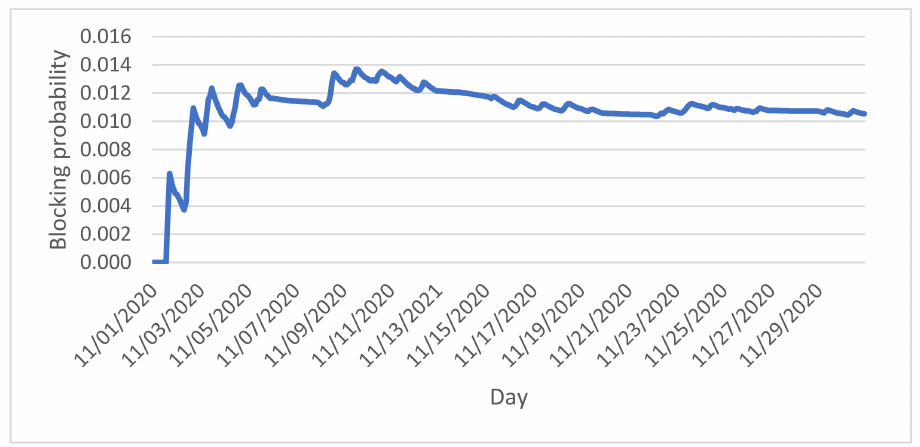
Figure 4. Estimated blocking probabilities for November